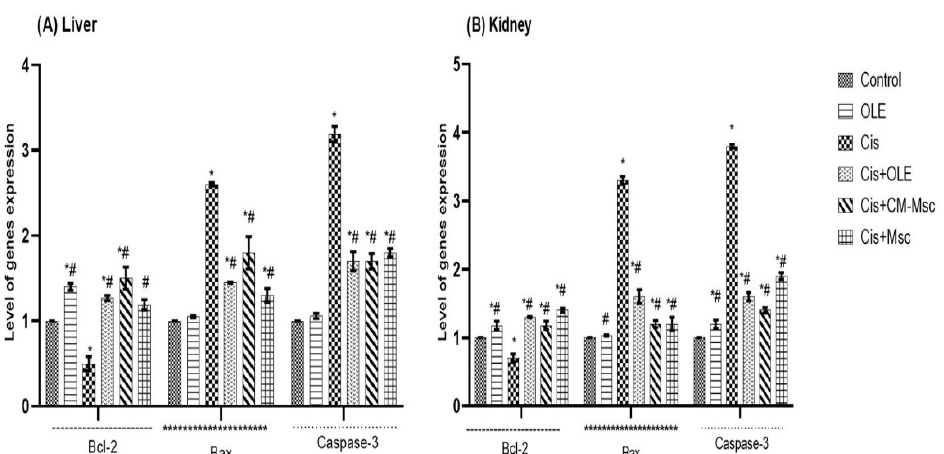
Figure 16. PCR for sry gene in the liver ( A ), kidney ( B ), spleen ( C ), and thymus gland ( D ) of rats; M: 100 bp DNA maker; sry: 104 bp, lane 1: Control positive; lane 2: Control negative; lane 3: OLE; lane 4: Cis; lane 5: Cis + OLE; lane 6: Cis + CM-MSC; lane 7: Cis + MSC.